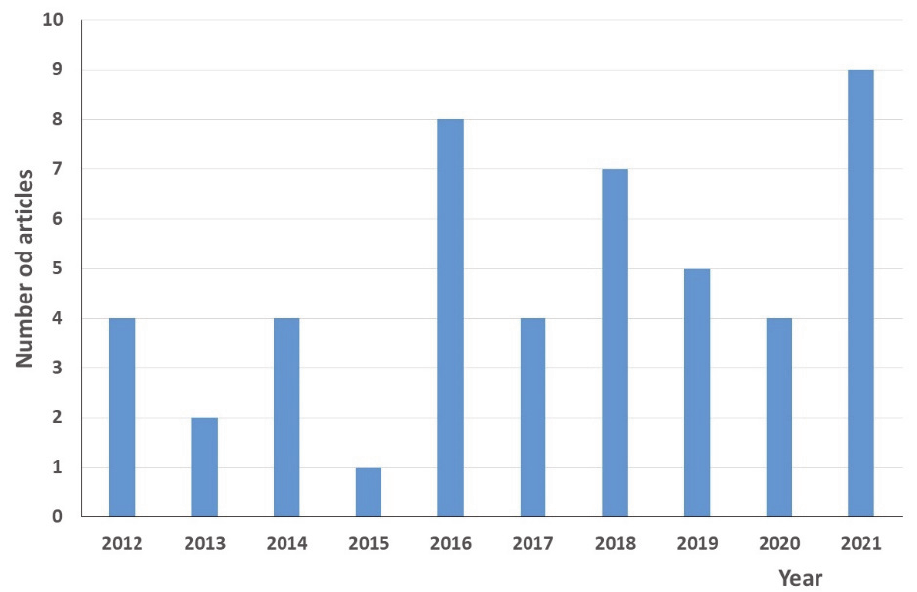
Figure 2. The number of articles in particular years.